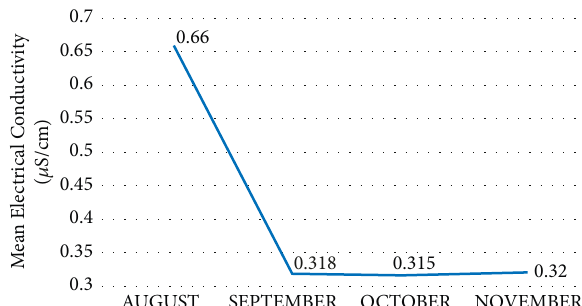
Figure 4: Mean levels of electrical conductivity in the Dankran